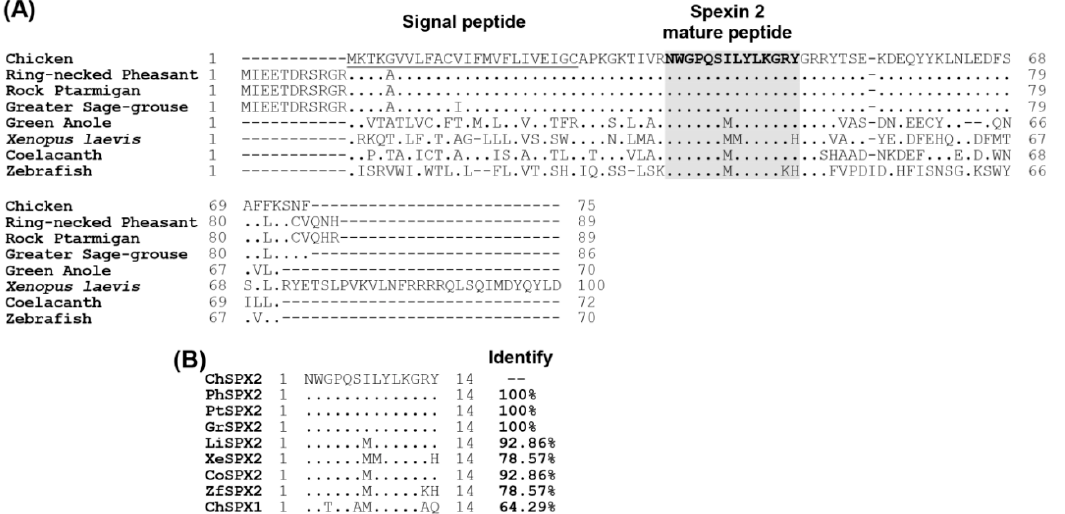
Figure 2. Amino acid sequence alignment of SPX2. ( A ) Multiple amino acid sequence alignments of chicken SPX2 with those of other species, including ring-necked pheasant (XM_031608967), rock ptarmigan (XM_048949770), greater sage-grouse (XM_042813209), green anole (KF601212), Xenopus laevis (XM_041589573), coelacanth (KF601216), and zebrafish (KF601217). The signal peptide is underlined and the mature peptides are shaded in gray. ( B ) Sequence conservation between chicken Spexin 2 mature peptide (ChSPX2) with ring-necked pheasant (PhSPX2), rock ptarmigan (PtSPX2), greater sage-grouse (GrSPX2), green anole (LiSPX2), Xenopus laevis (XeSPX2), coelacanth (CoSPX2), zebrafish (ZfSPX2), and chicken Spexin 1 mature peptide (ChSPX1). The identical amino acids are denoted by